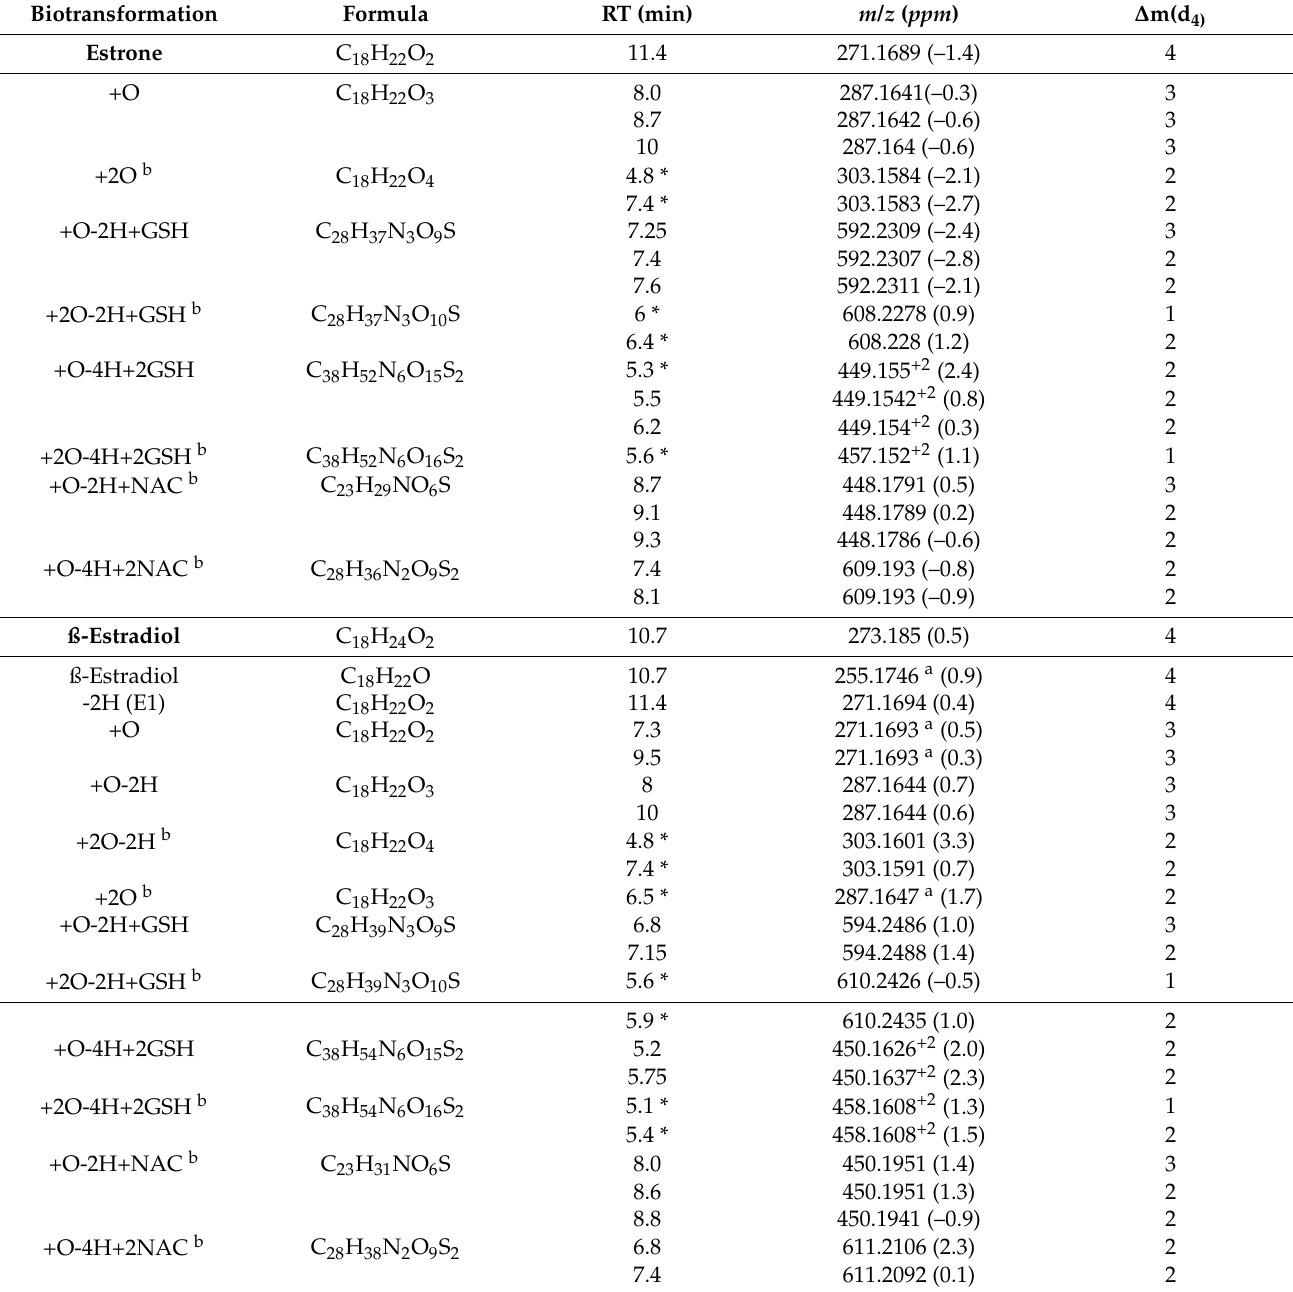
Table 1. Summary of metabolites and adducts characterized for E1, E2 and EE2 in human and rat liver